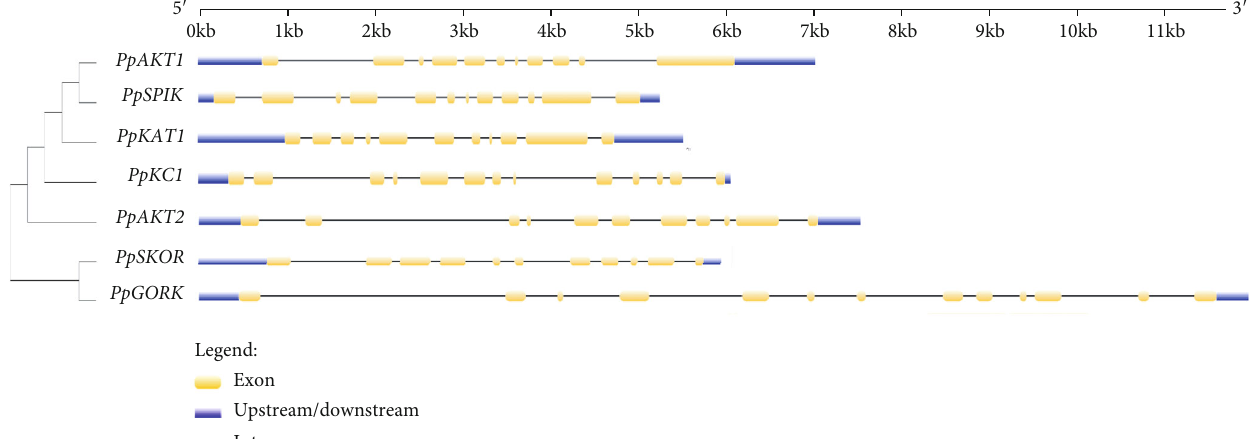
Figure 3: Gene structure analysis of the peach shaker K + channel genes. Table 2: Subcellular localization prediction of the peach shaker K + channel proteins a .